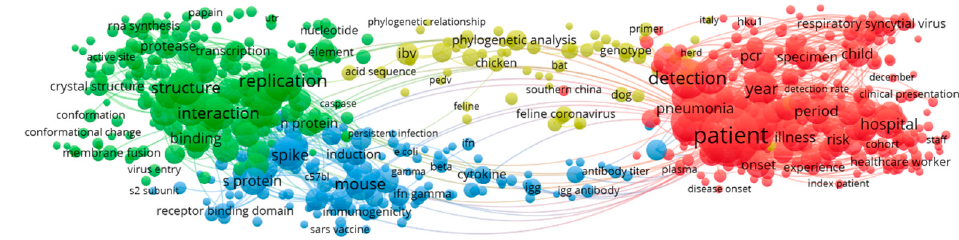
Figure 4. 2004–2007 Term Cooccurrence Map. Figure 4. 2004 – 2007 Term Cooccurrence Map. Figure 4. 2004 – 2007 Term Cooccurrence Map.